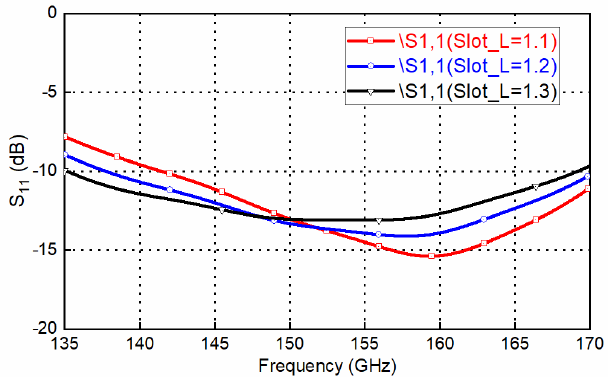
Figure 8. Effect of the slot width (slot_W) on the designed transition frequency response.